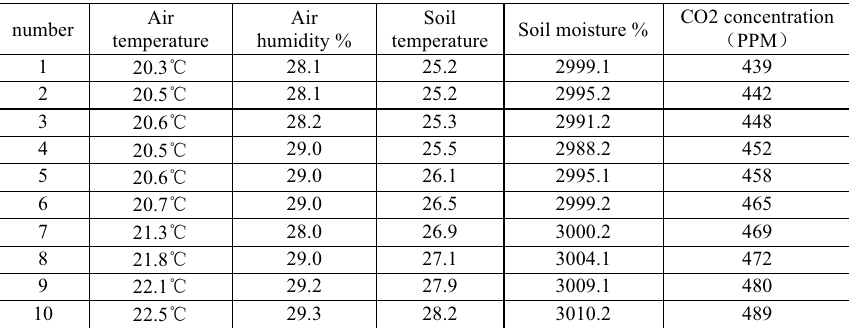
Table 2. The testing results of the Dedicated testing